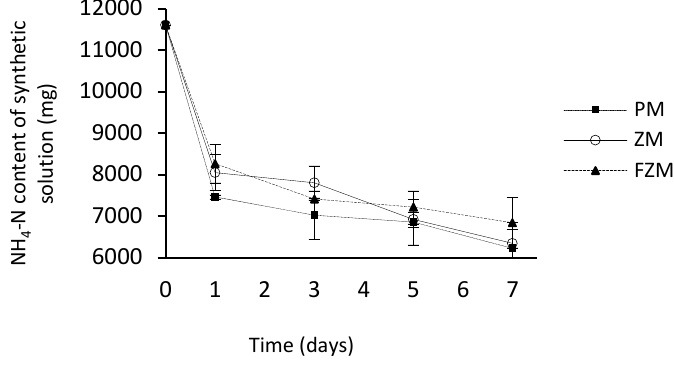
Figure 4. Mass of NH 3 –N remaining in the N emitting synthetic solution for three di ff erent types of ePTFE tubular membranes (experiment 1). Data points are means ± s.d. of duplicate experiments.